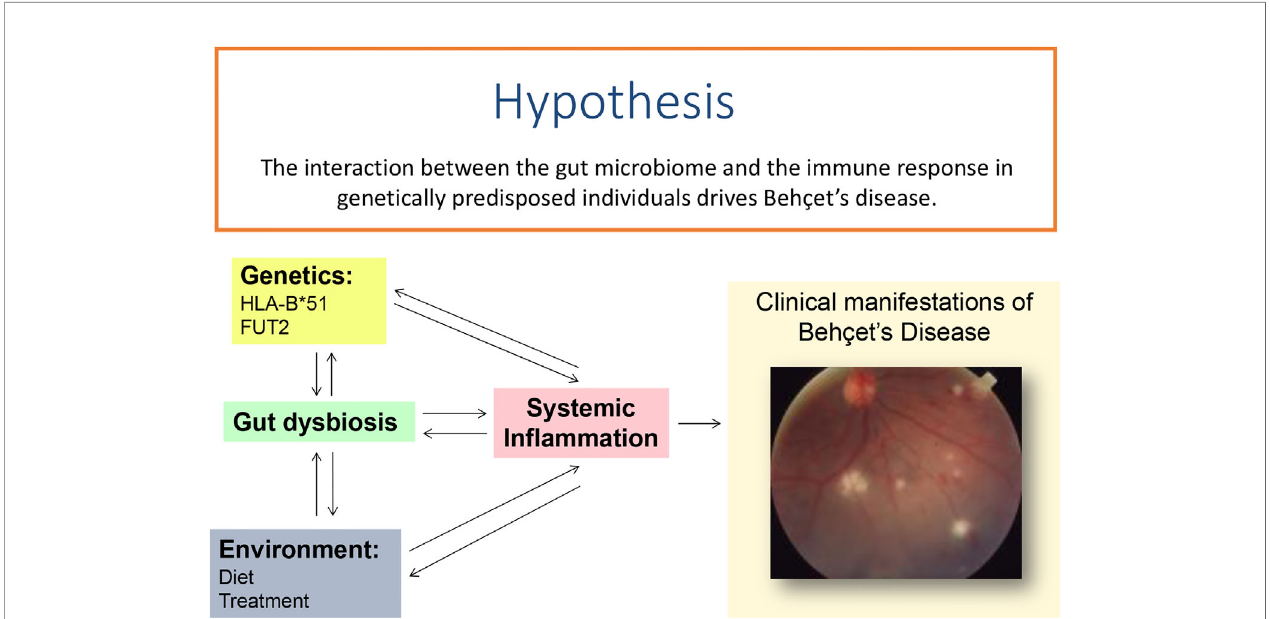
FIGURE 1 | Systemic in fl ammation leading to clinical features in Behc ̧ et ’ s disease may either be initiated by of causing changes in the gut microbiome in patients who are genetically predisposed to the